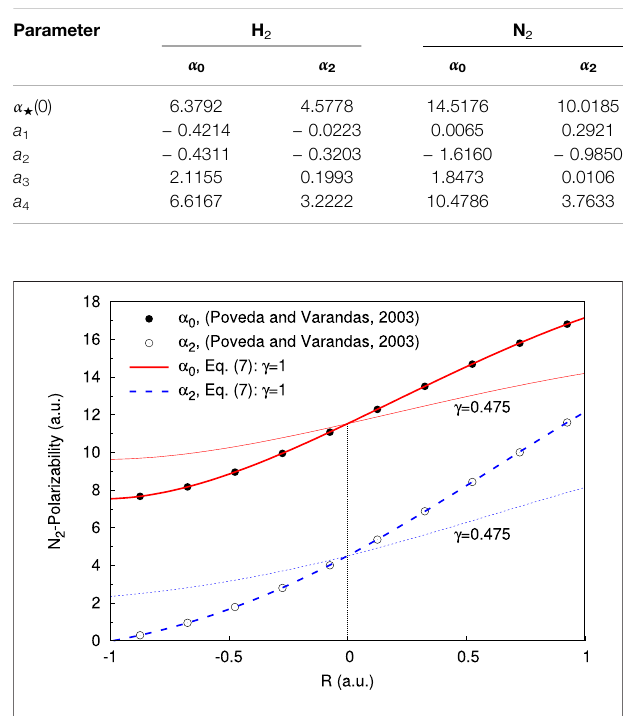
FIGURE 2 | (Color online) Isotropic ( α 0 ) and anisotropic ( α 2 ) dipole polarizabilities for the nitrogen molecule, as a function of the internuclear separation. The thick solid and dashed lines represents the fi ts of Eq. 7 with γ =1, to the ab initio data. The same curves for γ =0.475 are shown in thin lines (see text for details).